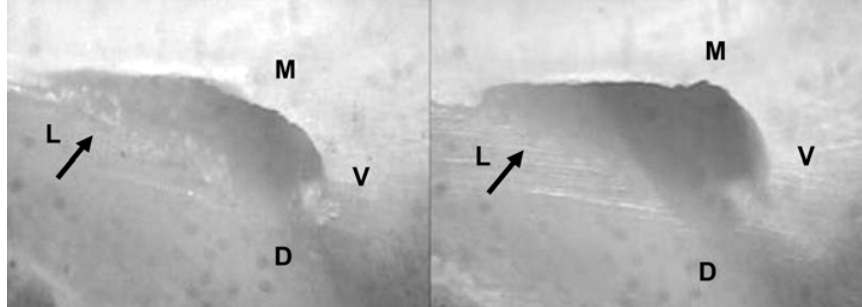
FIGURE 1- Preoperative image (left) and postoperative image (right) showing the absence of instrumentation at the lingual wall (arrow). M, mesial; D, distal; V, buccal; L, lingual